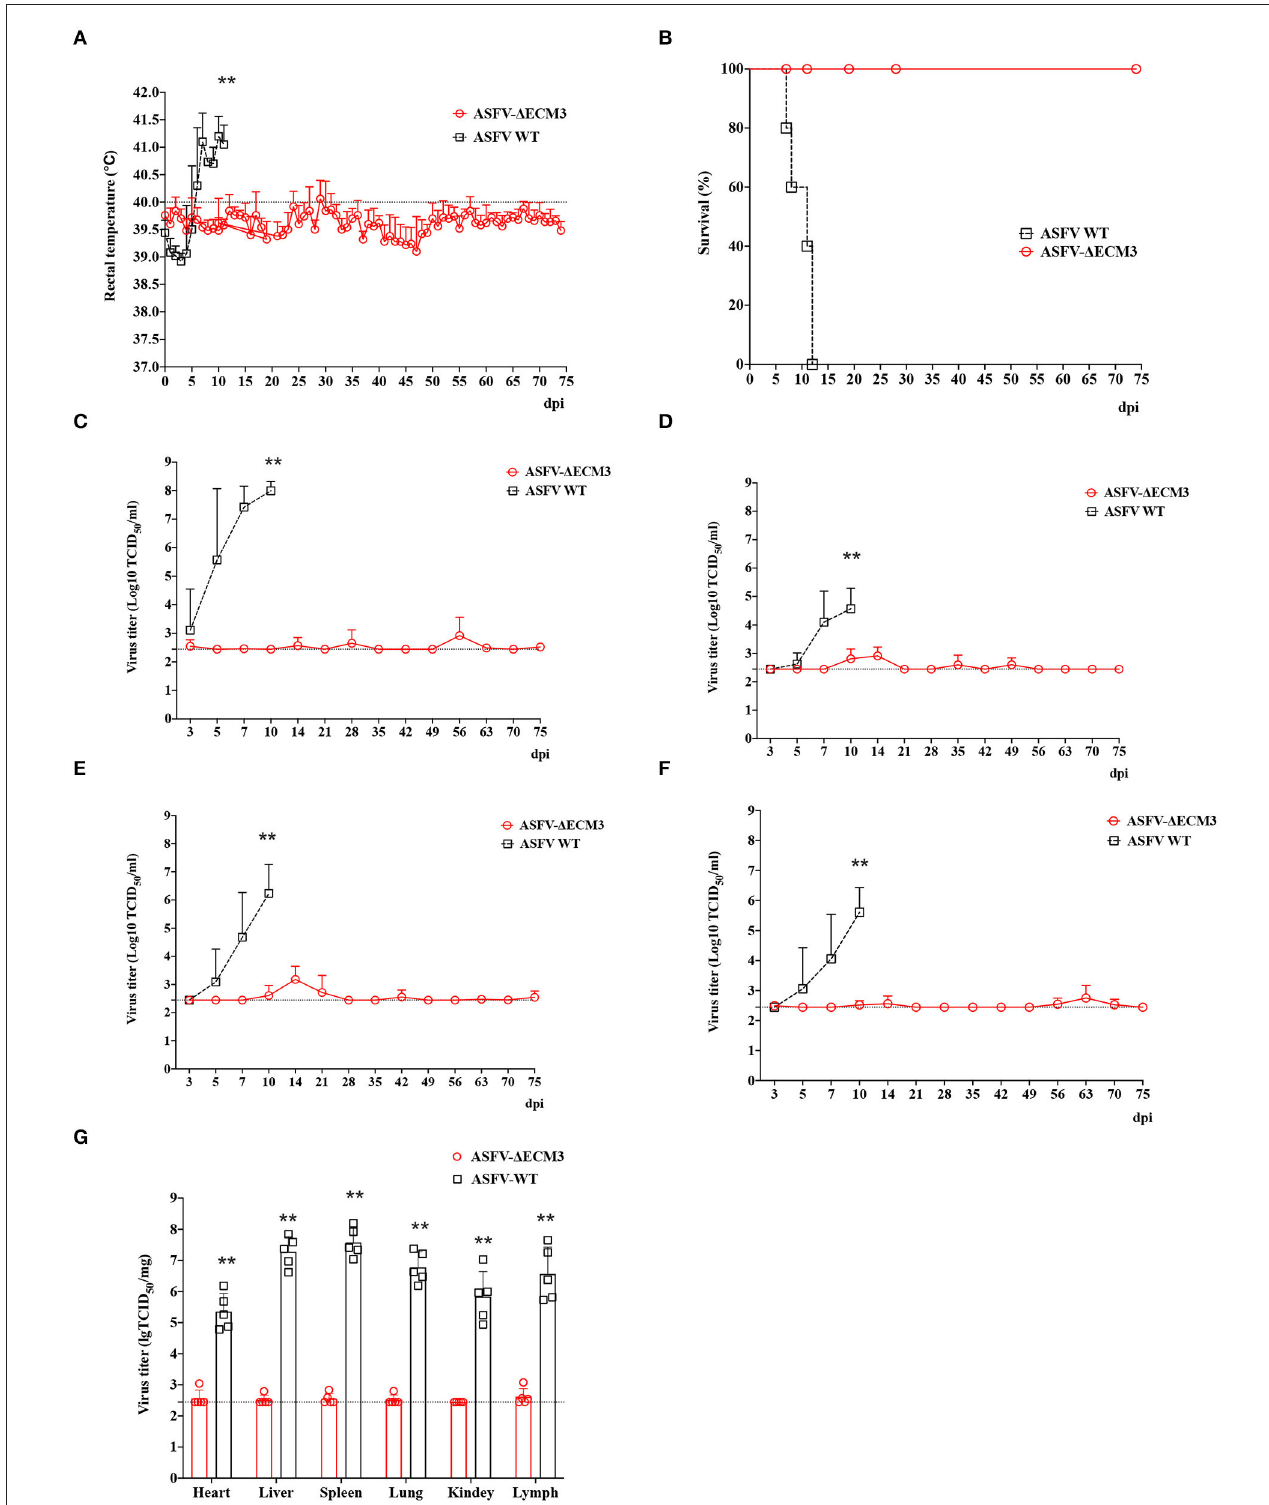
FIGURE 5 | The efficacy of ASFV- 1 ECM3 virus against ASFV-GZ201801 infection. (A) Body temperature in the ASFV- 1 ECM3 virus immunized piglets challenged with parental GZ201801. (B) Percentage of animals surviving after challenge. (C) Viremia titers were detected in piglets that were immunized with ASFV- 1 ECM3 virus after being challenged with the parental GZ201801 virus. Viral titers of oral swabs (D) , nasal swabs (E) , and anal swabs (F) were detected in piglets that were immunized with ASFV- 1 ECM3 virus after being challenged with parental GZ201801 virus. (G) The viral shedding in the tissues was measured. The sensitivity of virus detection was ≥ 10 2.45 TCID 50 /ml. ** p <